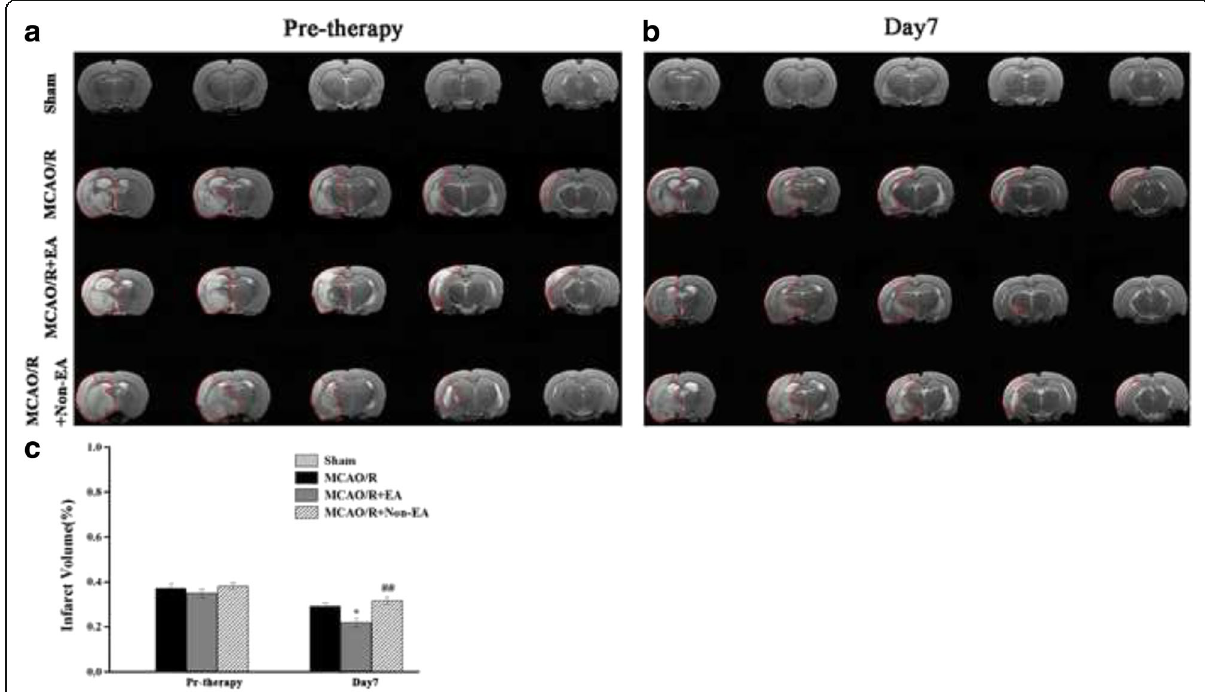
Fig. 3 Effect of EA on cerebral infarct volume assessed by T2-Weighted MRI in Rats. a , b T2WI images of five brain slices of different levels (L10 – L14 slices) from five different rats in each group before treatment and at Day 7 after EA. The ischemic lesion corresponds to the hyperintense region on each image. c The high intensity volume of T2WI calculated over all slices (infarct volume/volume of whole brains). Data are shown as mean ± S.E.M from 12 individual rats in each group. * P < 0.05, the MCAO/R + EA group versus the MCAO/R group; ## P < 0.01, the MCAO/R + EA group versus the MCAO/R+ Non-EA